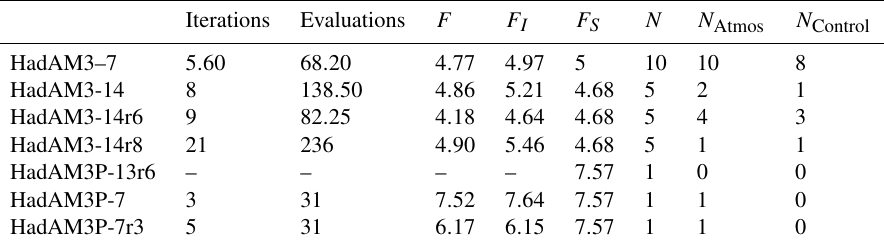
Figure 2. Normalised parameter values ( y axis) for default HadAM3 (black diamond), optimised 7-parameter (blue) and 14-parameter (red) cases. The x axis shows the parameter. Shown are the 25–75% values (boxes), the median values (black horizontal line) and the ranges (vertical lines). Pale hatching shows where the null hypothesis that the optimised parameters are uniformly distributed in the range 0–1 is not rejected at the 10% value using a Kolmogorov–Smirnov test. Where this null hypothesis is rejected the inter-quartile boxes are edged in black. Table 5. Algorithm summary. For each algorithm is shown the expected number of iterations, evaluations, mean cost from final optimisation simulations ( F ), mean cost from independent atmospheric simulations ( F i ), mean cost from standard configuration ( F s ), number of cases run ( N ), number that converged ( N Atmos ) and number that were “good” coupled models ( N Control ). The algorithm name shows the model, number of parameters varied, and, if the random block-coordinate variant is used, then rP rand denotes that P rand parameters, selected at random on each iteration, were